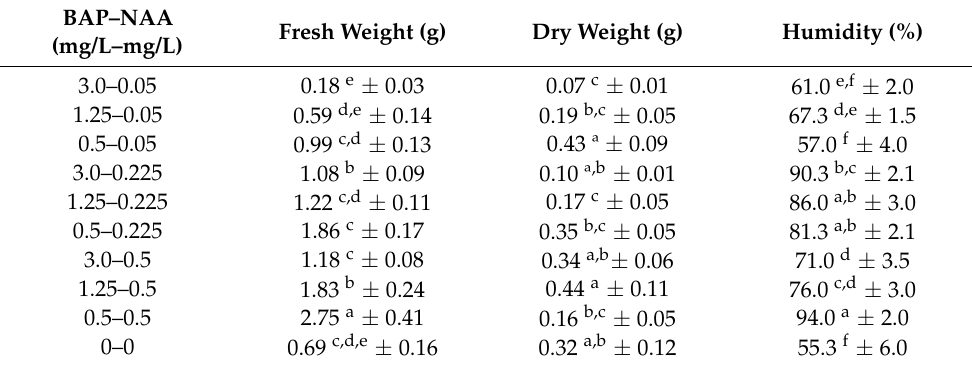
Table 6. Fresh weight, dry weight and humidity content of T. officinale callus derived from hypocotyls induced under different NAA/BAP combinations (medium MS supplemented with sucrose 2.3% at 18 ± 2 ◦ C and 0/24 h light/dark, four weeks after